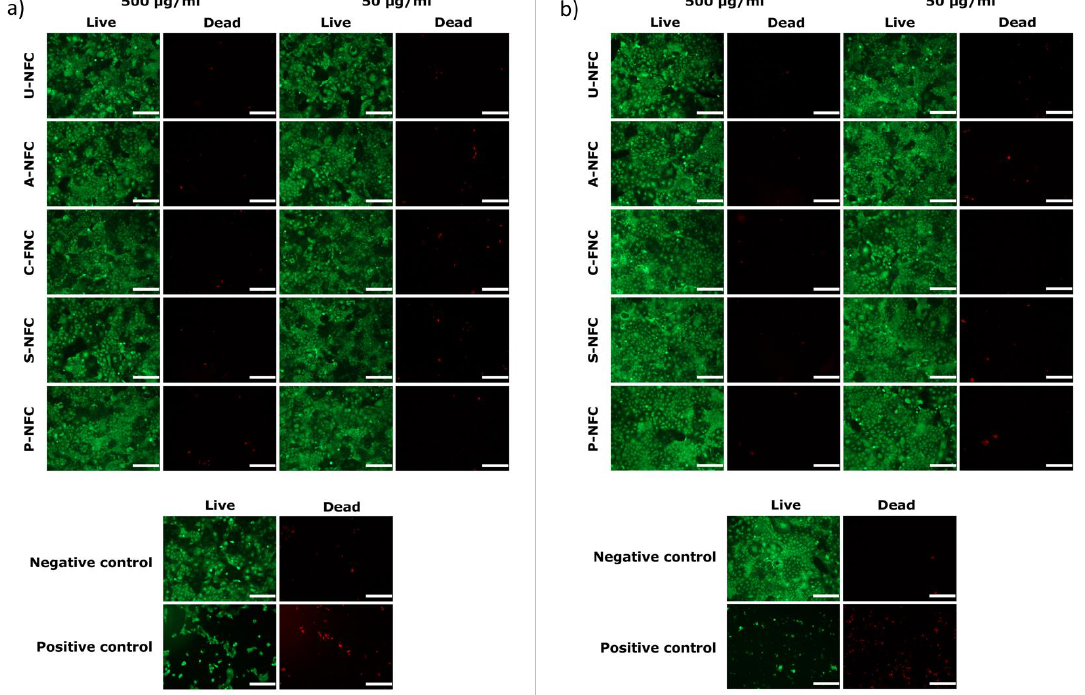
Figure 4. Representative live / dead images of Caco-2 cells after ( a ) 24 h and ( b ) 48 h exposure to the NFC materials. Scale bar represents 100 µm.